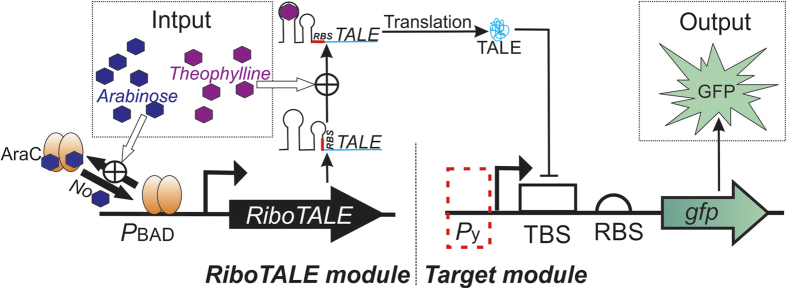
Schematic of a representative RiboTALE repression system.The RiboTALE repression system consists of an inducible RiboTALE module and one or more targets. The RiboTALE module is comprised of a Riboswitch and a TALE gene. The RiboTALE module is initially repressed by AraC and is only activated in the presence of arabinose. In the latter case, the RiboTALE expression cassette is expressed, but the mRNA is not translated in the absence of the riboswitch signal (here theophylline). In the presence of theophylline, the riboswitch changes its conformation, exposes the Ribosomal Binding Site (RBS) so that the ribosome can bind, which results in the synthesis of active RiboTALE proteins that in turn bind to the TALE binding site (TBS) present in the target module. Py is either PTet or PConst promoter.